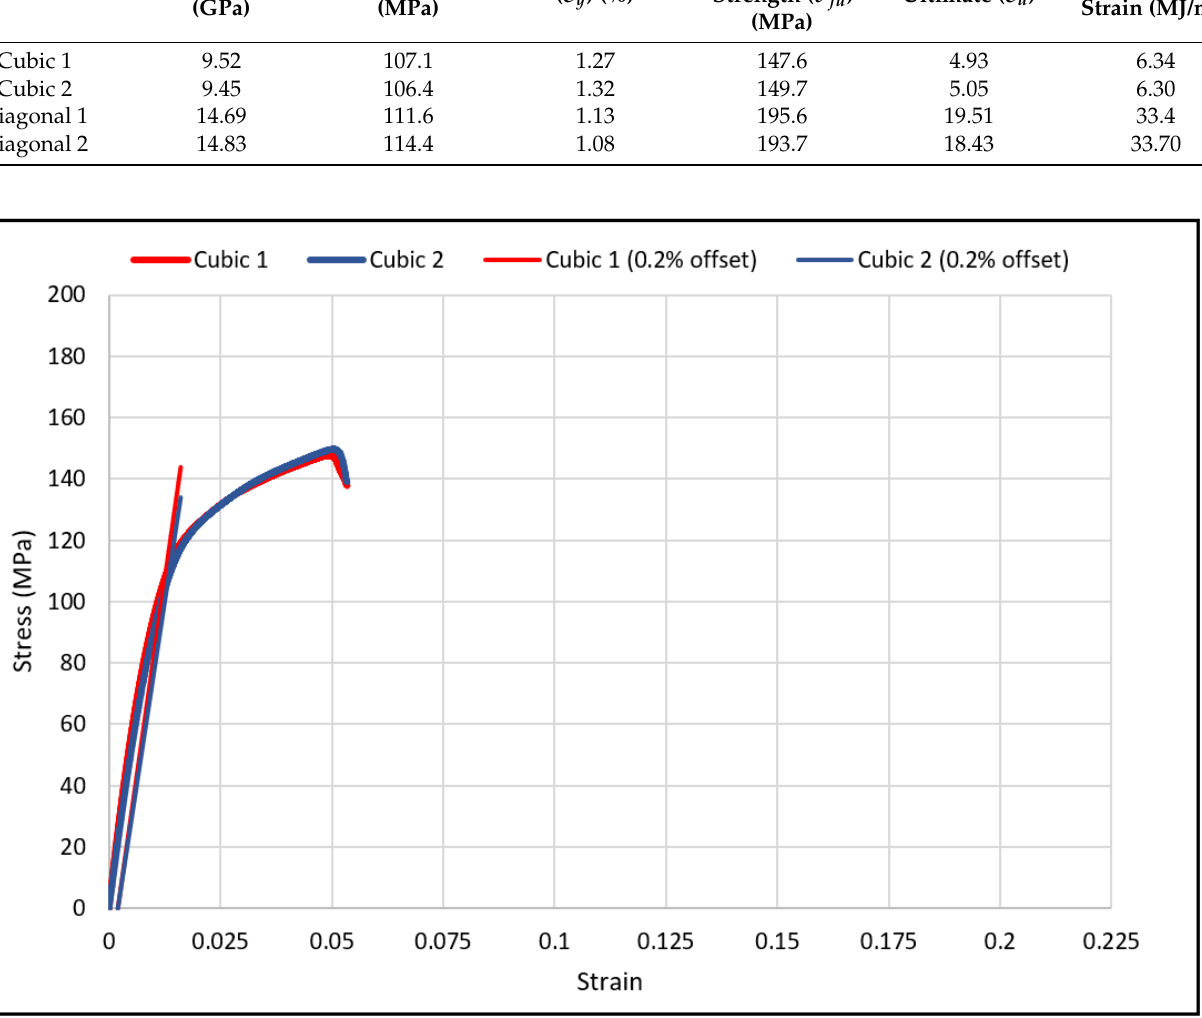
Figure 7. The 0.2% offset yield strength for cubic scaffolds. The bending modulus was 36% higher in the diagonal scaffold than in the cubic scaffold. Similarly, the ultimate flexural strength was 24% higher for the diagonal scaffold than for the cubic scaffold. When comparing the yield strength and yield strain of both designs, no significant differences were observed. The yield strength of the diagonal scaffold was slightly higher than the cubic scaffold, whereas the yield strain was a bit lower for the diagonal scaffold than the cubic scaffold. Substantial differences were observed when comparing the strain at ultimate and energy absorption. The ultimate strain for the diagonal scaffold was 280% higher than the cubic scaffold, and the energy absorption was 430% higher in the diagonal unit cell design compared with the cubic design. Hence, the diagonal scaffold was observed to be significantly tough and can absorb substantial energy before fracture in bending. The deformed shapes for both scaffolds in bending are shown in Figure